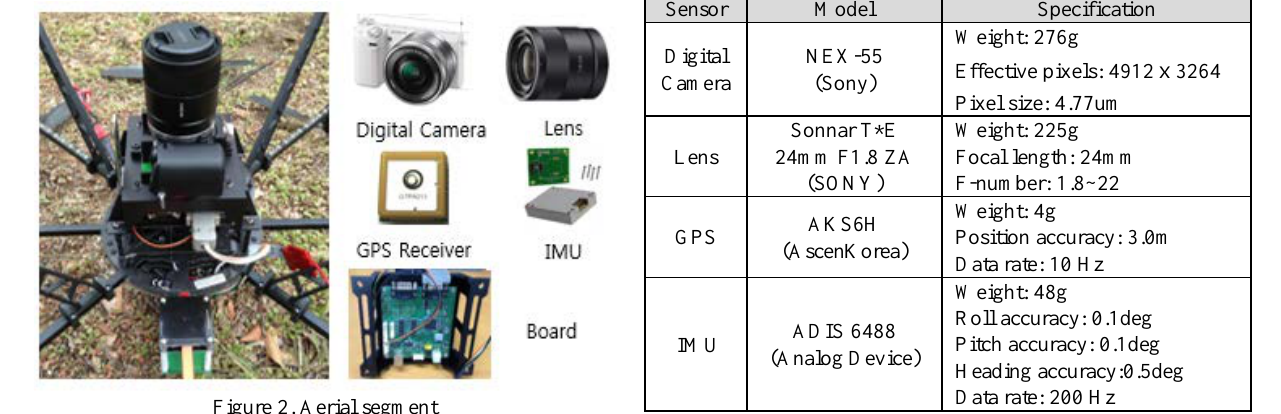
Table 2. Main specifications of the